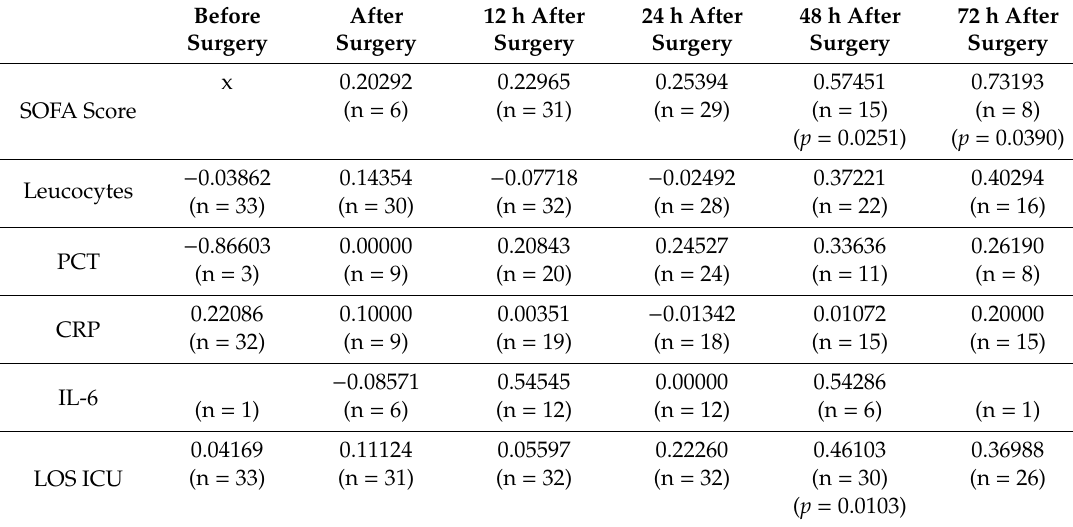
Table 3. Spearman’s correlation coe ffi cient for RNase 1 and perioperative variables. The number of included patients is shown below the coe ffi cient. If the coe ffi cient was statistically significantly di ff erent from 0, a p -value is stated below the number.